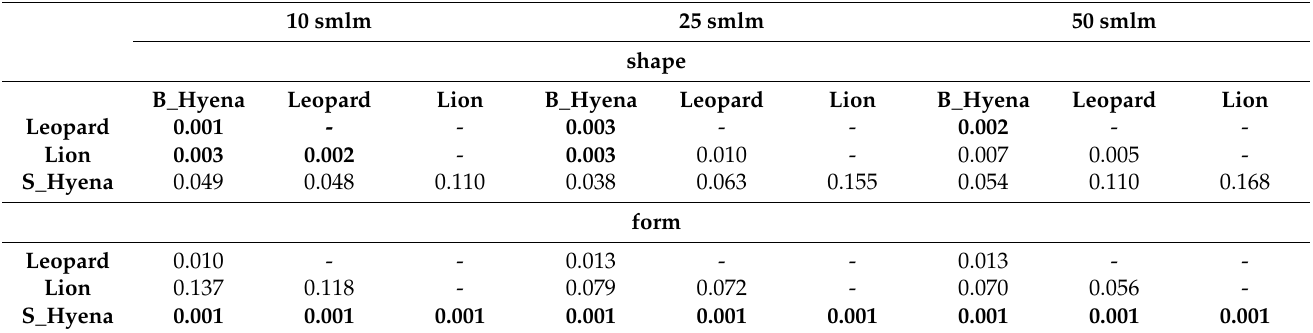
Table 5. MANOVA p -values obtained on the 10, 25, and 50 semilandmark (smlm) models used to describe the cross-sections at 50% of the score length, using an EFA approach. Statistical significance ( p < 0.003) is marked in bold.